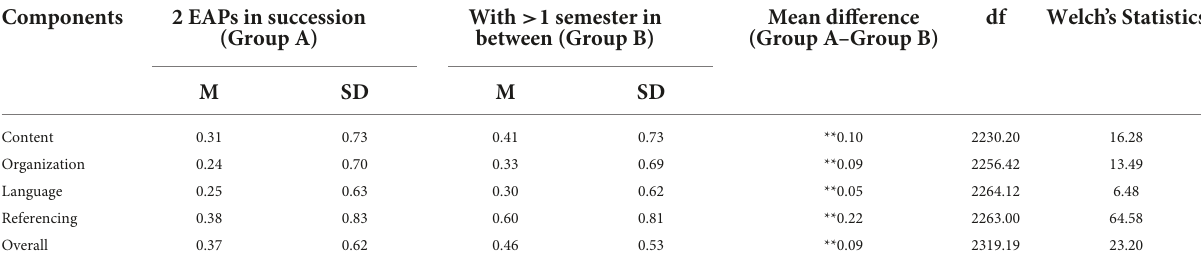
TABLE 5 Progression of students (by time elapsed between the two EAP courses).